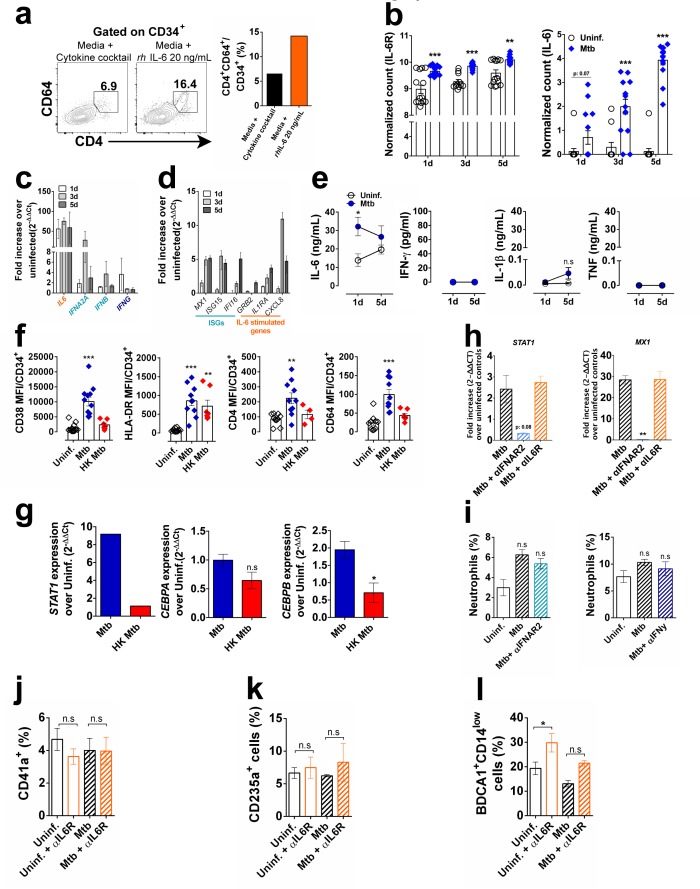
Gene expression and cytokine production during myeloid differentiation in vitro.(a) CD34+ cells were stimulated with or without recombinant IL-6 (20 ng/mL) for 5 days and frequency of CD4+CD64+CD34+ cells were measured by flow cytometry. (b) normalized counts from RNA-seq data as determined by library size normalization. Results are means ± SEM of data pooled from two independent experiments (eight replicates). ***p≤0.001 between Mtb vs uninfected groups at different time points. CD34+ cells were exposed to Mtb (MOI3) and at days 1, 3 and 5 p.i. qPCR was performed for quantification of (c) IL6/IFN cytokines and (d) ISGs and IL-6-induced genes. (e) IL-6, IFN-γ, IL-1β and TNF measurements from unexposed or Mtb-exposed purified CD34+ cell culture supernatants at day 1 and 5 p.i. Open circle: uninfected control. Blue circle: Mtb-infected group. Results are means ± SEM of data pooled from 6 to 8 independent experiments. *p≤0.05 between 1d Mtb vs uninfected groups. (f) purified CD34+ cells were exposed to live or HK-Mtb (MOI3) and 5 days later, CD38, HLADR, CD4 and CD64 MFI calculated within CD34+ events. Results are means ± SEM of data pooled from five independent experiments. **p≤0.001; ***p≤0.0001 between Mtb or HK Mtb vs uninfected groups. (g) CD34+ cells were exposed to live or HK-Mtb (MOI3) and at days 5 p.i., qPCR was performed for quantification of STAT1, CEBPA and CEBPB. Results are means ± SEM of data pooled from three independent experiments. *p≤0.05 between Mtb vs HK Mtb groups. (h) CD34+ cells were exposed to live Mtb (MOI3) in the presence or absence of α-IFNAR2 or α-IL-6R and at day 5 p.i., qPCR was performed for quantification of STAT1 and MX1. **p≤0.001 between Mtb vs Mtb+αIFNAR2 groups. CD66b+CD16+ neutrophil frequencies in 10 day culture of Mtb-exposed CD34+ treated with (i) α-IFNAR2 (1 µg/ml) or α-IFN-γ (10 µg/ml) blocking antibodies. (j,) CD41+ megakariocytes; (k) CD235+ erythrocytes and (l) BDCA1+CD14low myeloid DC frequencies in 10 day culture of Mtb-exposed CD34+ treated with α-IL-6R blocking or control antibodies.10.7554/eLife.47013.017Figure 4—figure supplement 1—source data 1.Raw data from Figure 4—figure supplement 1.